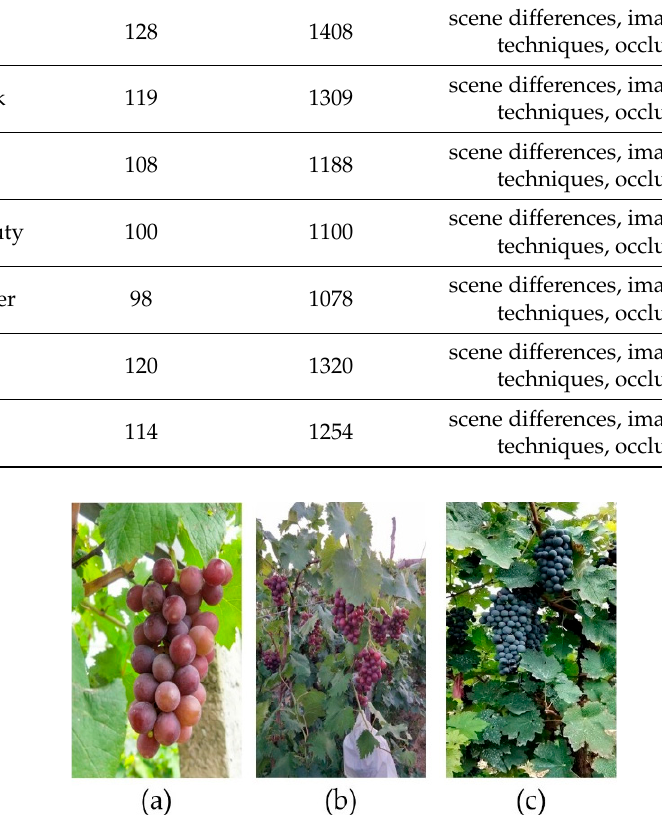
Figure 2. Different species of grapes vary in color, shape, compactness and texture: ( a ) Kyoho ripe grapes; ( b ) Midknight Beauty ripe grapes; ( c ) Syrah ripe grapes.